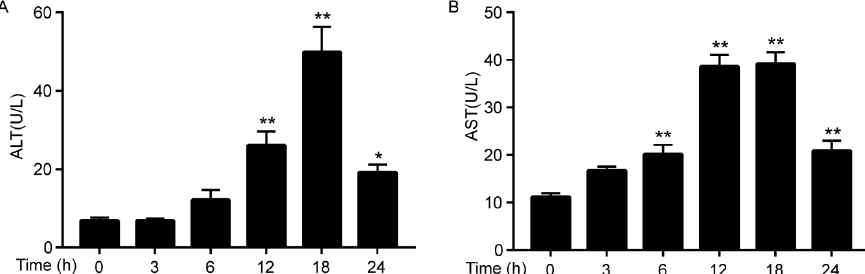
Figure 1. Cd-induced elevated serum Alanine (ALT) ( A ) and aspartate aminotransferase (AST) ( B ) activities in mice. Data were expressed as means ± SEM ( n = 8). * p < 0.05, ** p < 0.01 compared to control.